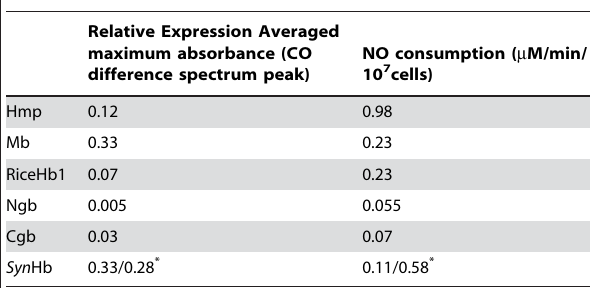
Table 2. In vivo expression and NO consumption